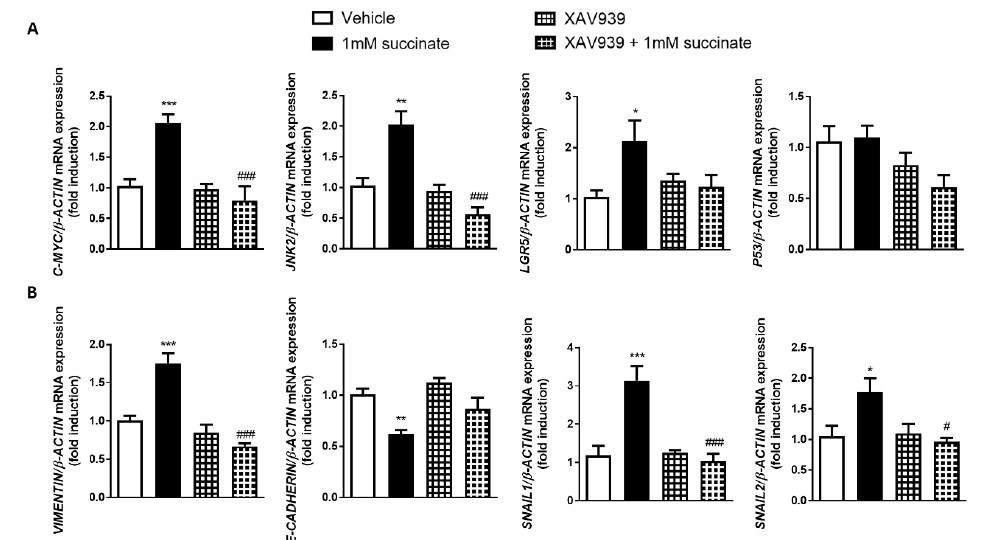
Figure 6. Succinate activates EMT through Wnt signaling pathway in intestinal epithelial cells. HT29 cells were treated with 1 mM of succinate and with the inhibitor of the Wnt pathway, XAV939 (1 µ M) during 48 h. ( A ) Graphs show the expression of the Wnt target genes C-MYC, JNK2, LGR5 and of the tumor suppressor P53 ( n = 5). ( B ) Graphs show the expression of the EMT markers VIMENTIN, E-CADHERIN, SNAIL1 and SNAIL2 ( n = 5). Bars in graphs represent mean ± SEM, and significant di ff erences vs. non-treated HT29 cells are shown by * p < 0.05, ** p < 0.01 or *** p < 0.001, and vs. HT29 treated with 1 mM of succinate are shown by # p < 0.05 or ### p <